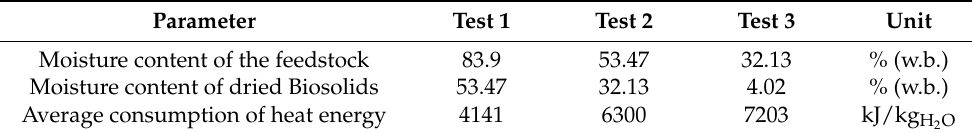
Table 3. Moisture and energy values from Tic et al. (2018) drying experiments.